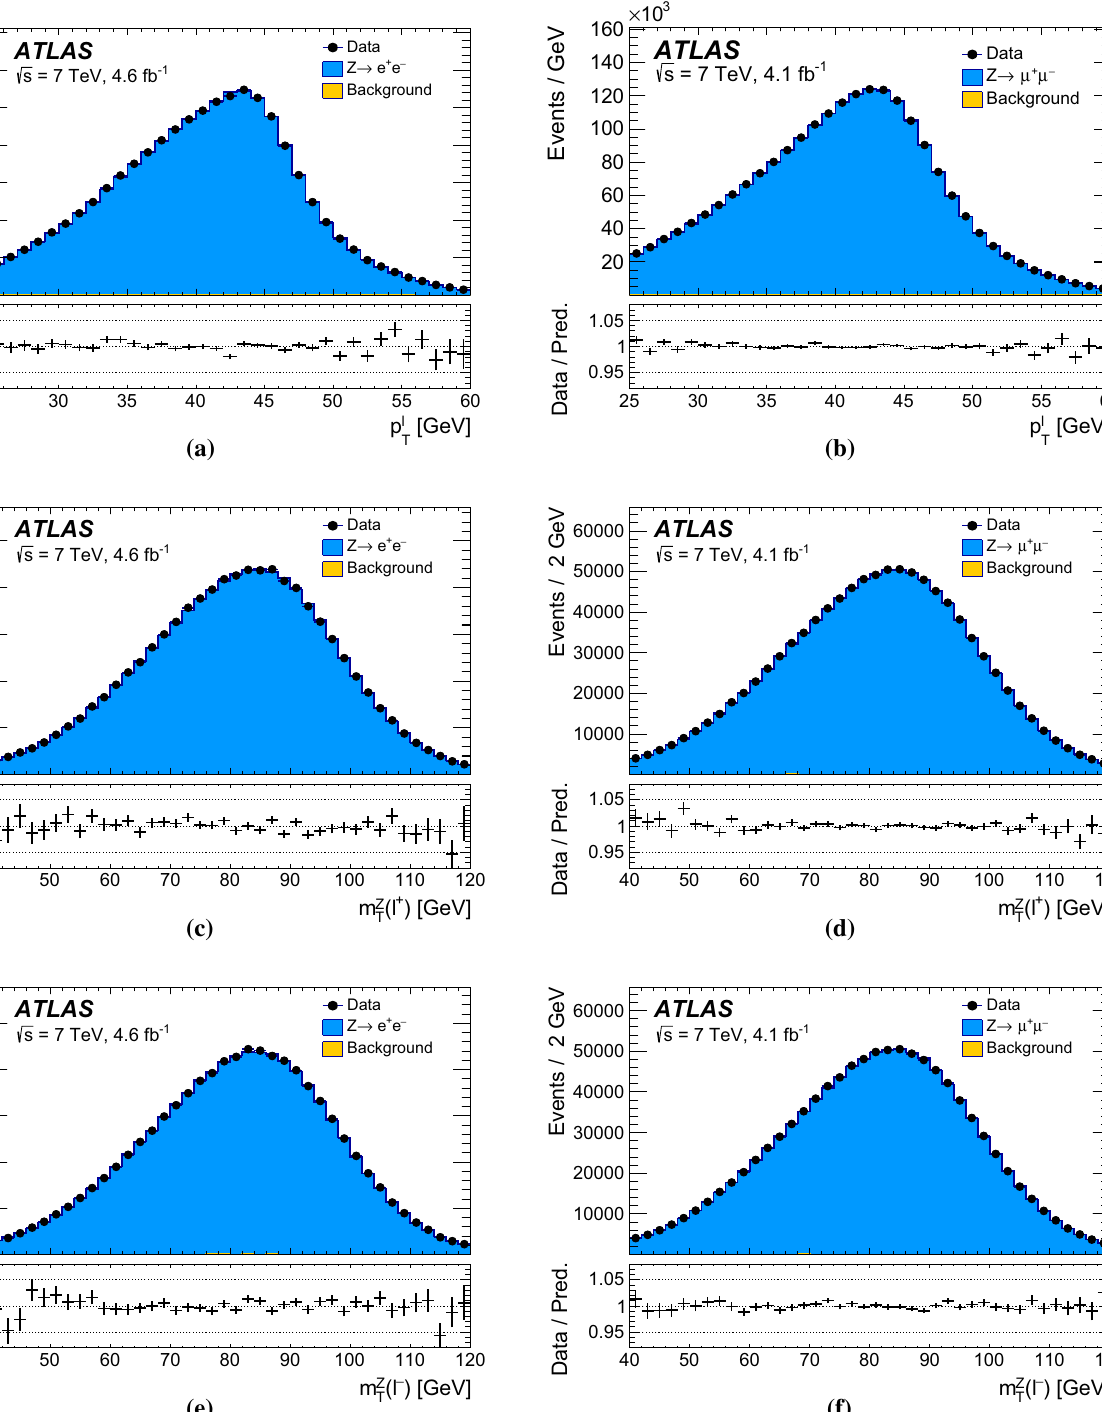
tions are applied to the simulated events. Background events contribute less than 0.2% of the observed distributions. The lower panels show the data-to-prediction ratios, with the error bars showing the statistical